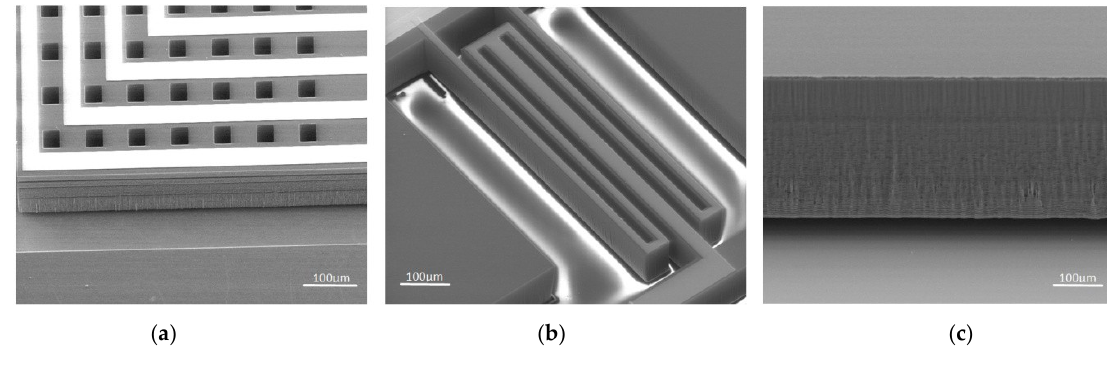
Figure 4. Fabrication results for the ( a ) coil, ( b ) folded beam, and ( c ) sidewall.